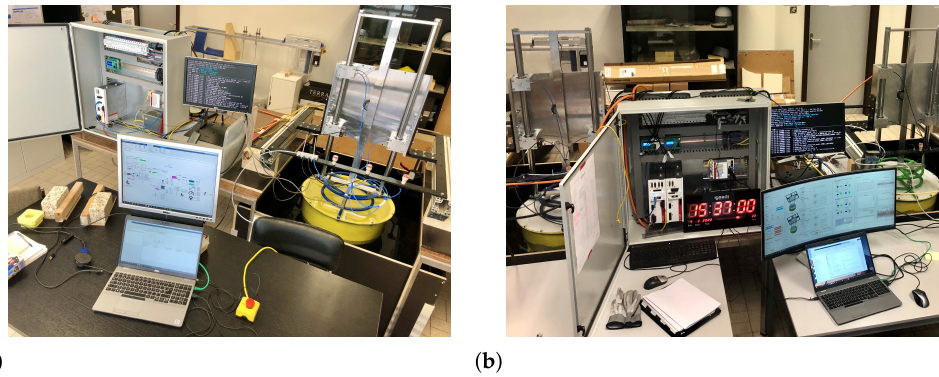
Figure 21. “WECfarm” experimental setup at the Coastal Engineering Research Group of Ghent University (Belgium): ( a ) single WEC; ( b ) two WEC